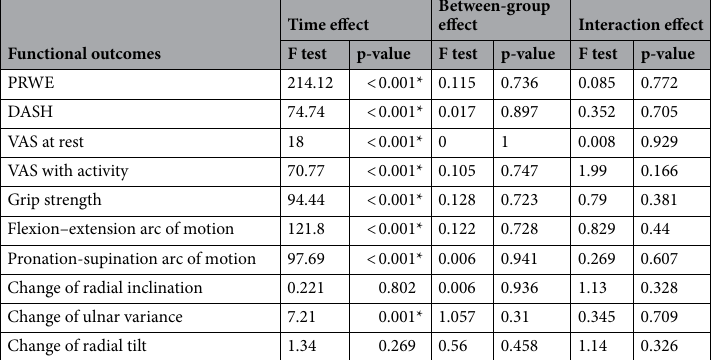
Table 4. Between-group differences of the functional outcomes and radiographic parameters. Linear mixed model. PRWE patient-rated wrist evaluation, DASH disabilities of arm, shoulder, and hand, VAS visual analog scale pain